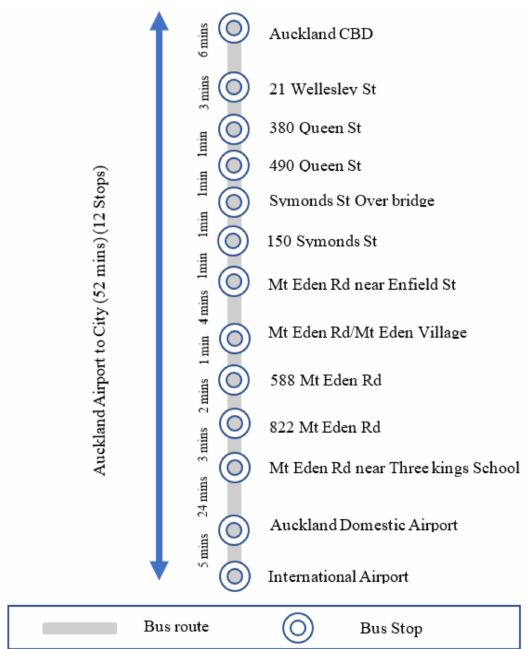
Figure 3. Skybus route between Auckland Airport and Auckland central business district